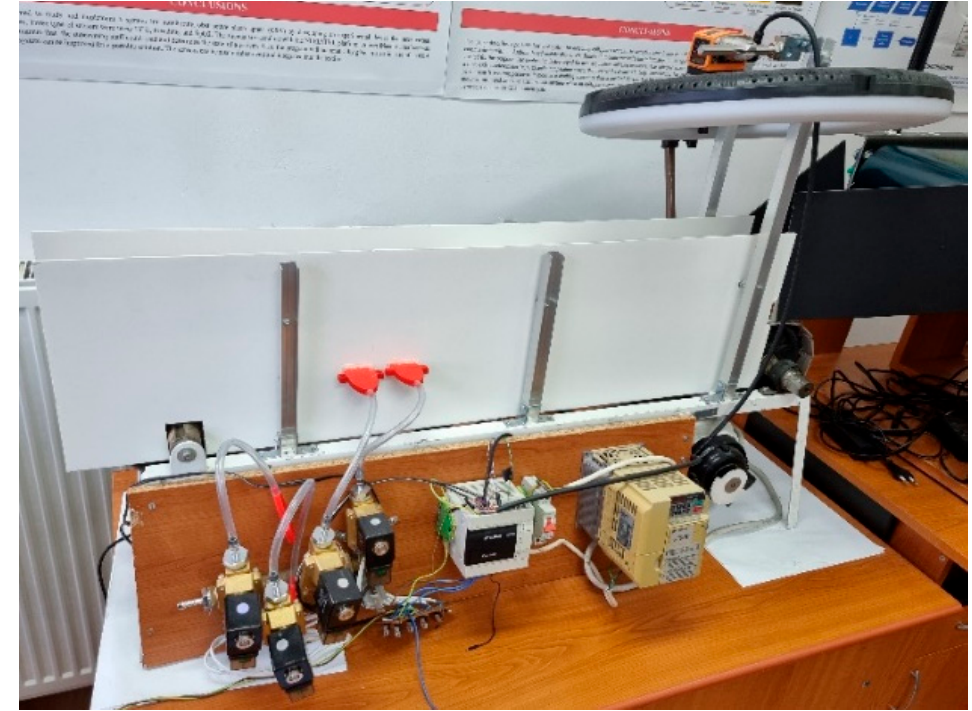
Figure 10. The second stage of the experimental sorting stand.